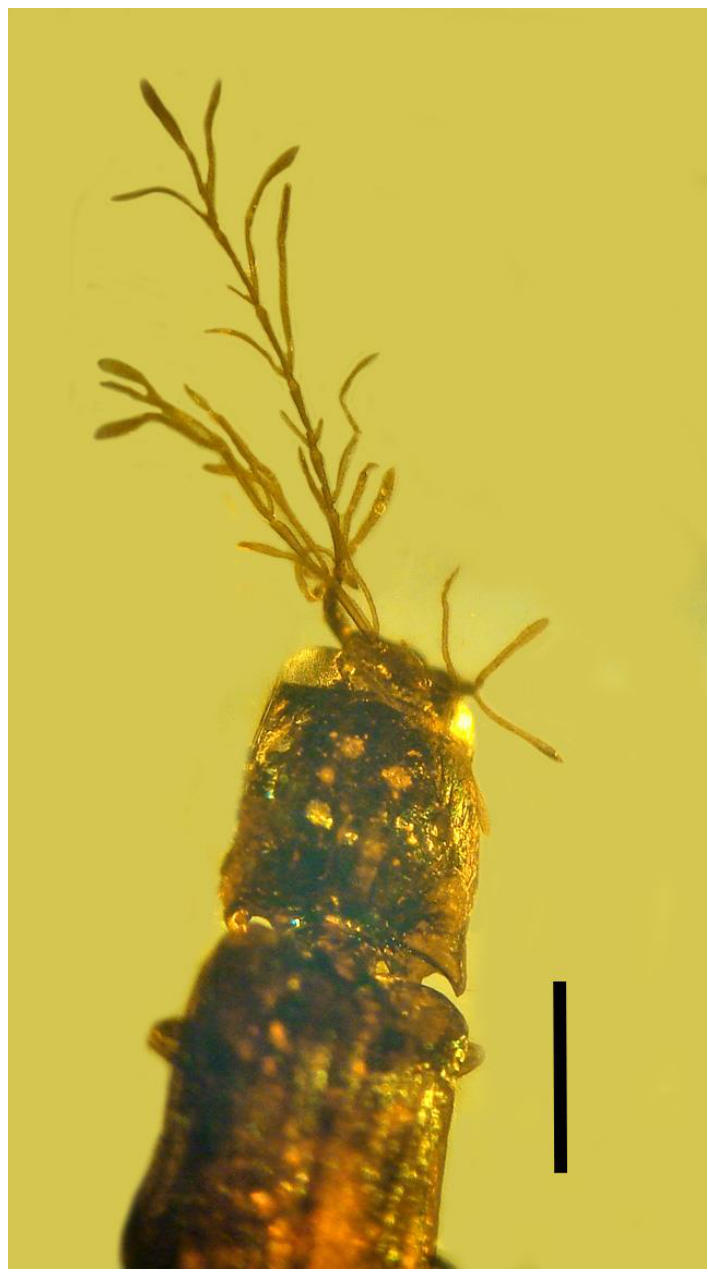
Figure 25. A trichomycete, Priscadvena corymbosa (Priscadvenales: Priscadvenaceae) emerging from the oral cavity of an elaterid beetle (Coleoptera: Elateridae) in Burmese amber. Scale bar = 1.0 mm.